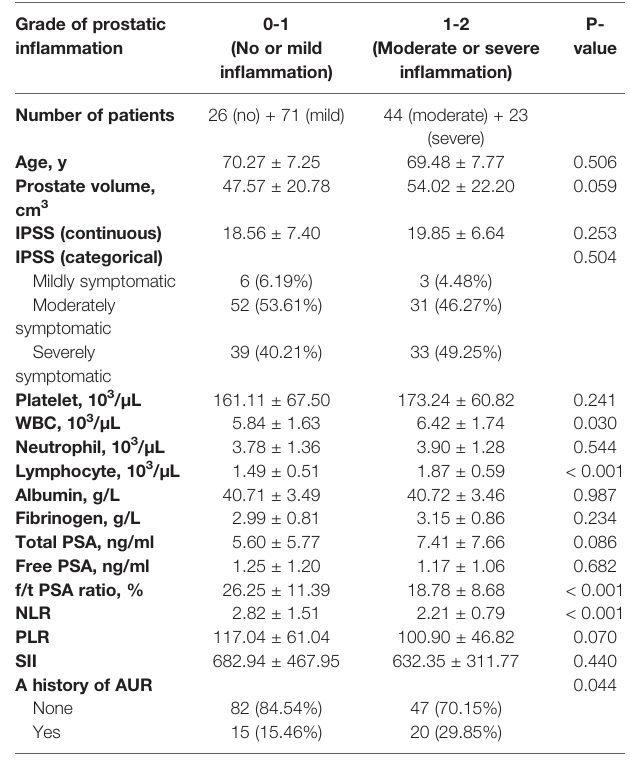
TABLE 1 | Baseline characteristics of patients.